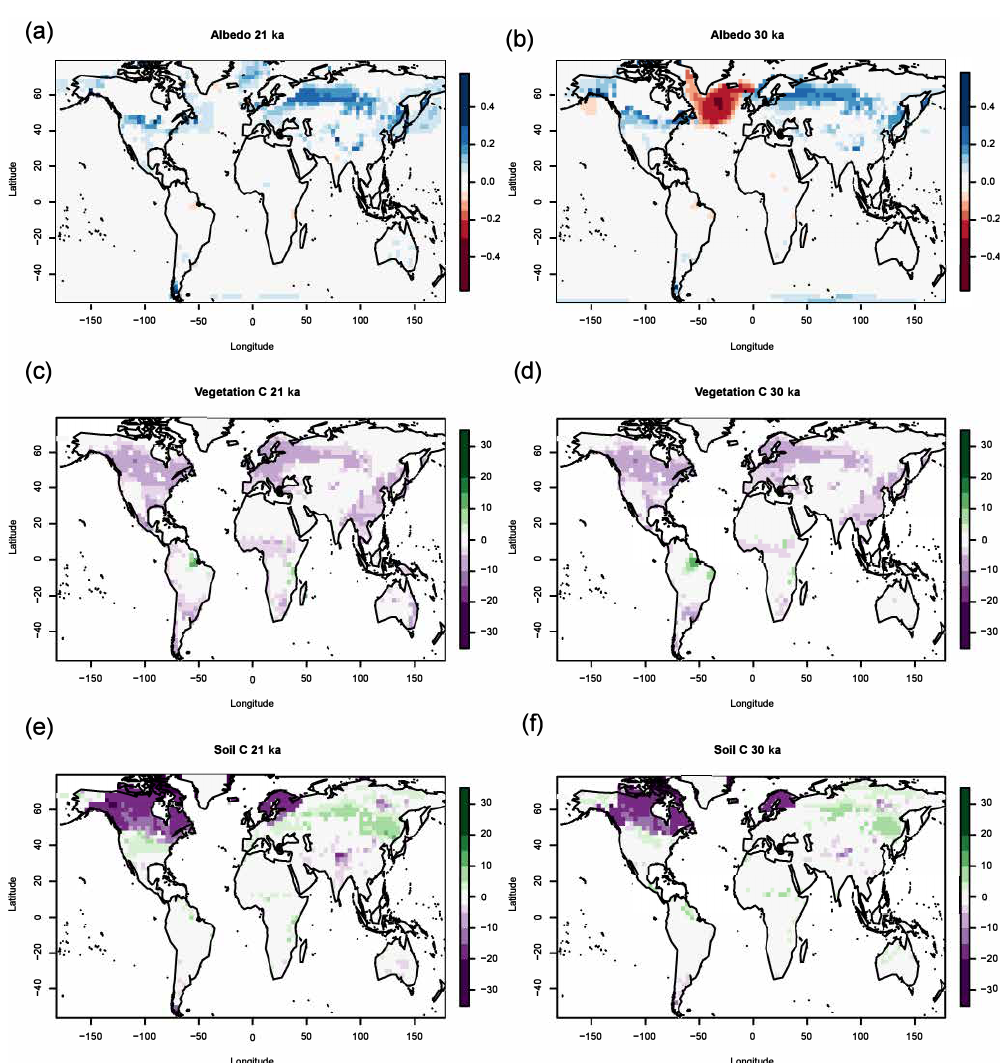
Figure A4. Mean annual anomaly of (a, b) surface albedo (unitless), (c, d) vegetation carbon (kgCm − 2 ), and (e, f) soil carbon (kgCm − 2 ), between the Dynamic vegetation simulation and the equivalent Static vegetation simulation. For 21ka ( a , c , e ) and 30ka ( b , d , f ). The pattern of reduced surface albedo at 30ka is similar to the pattern at 56 and 100ka. Since in the Static simulations the carbon remains at PI levels, panels (c) – (f) also represent the anomaly to PI. This figure includes the carbon under ice